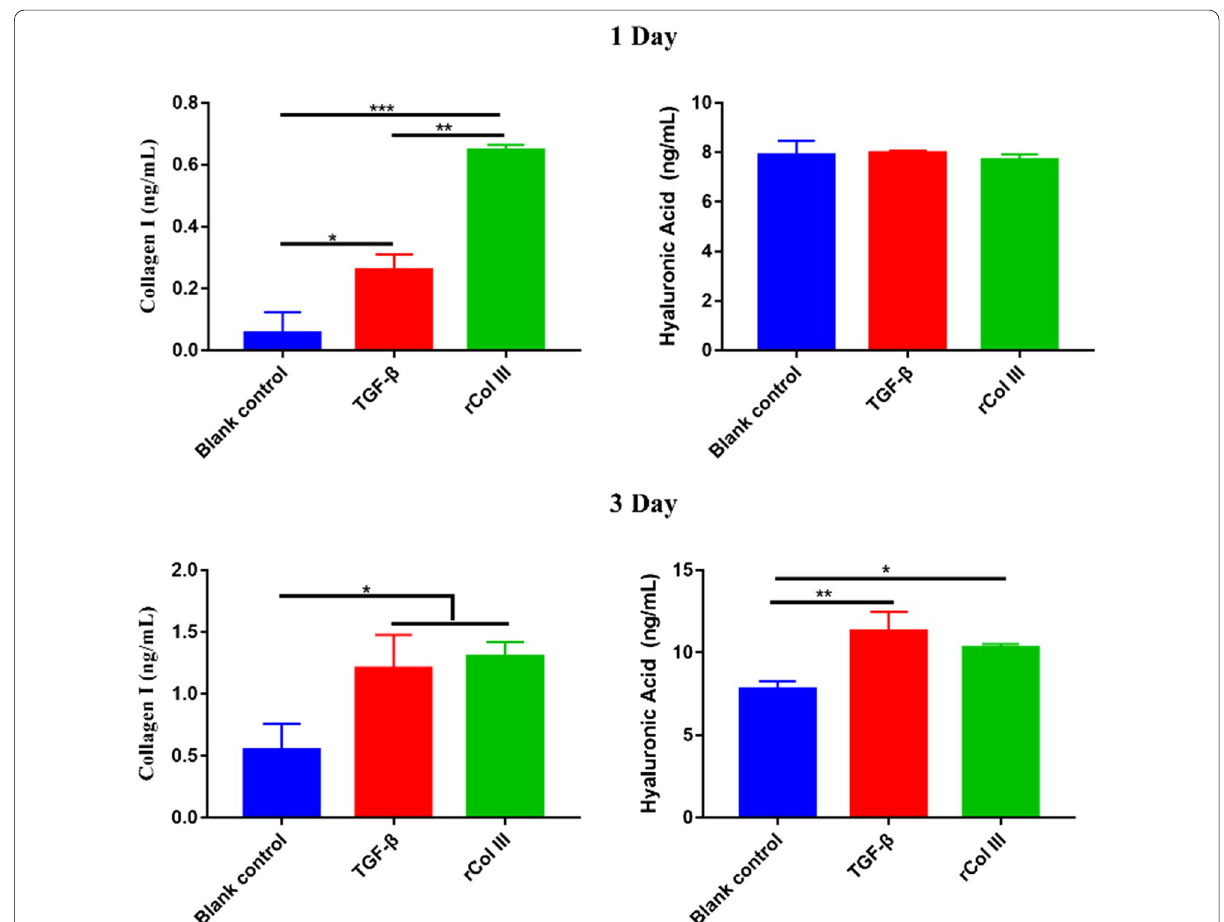
Fig. 8 Effect of rhCol III and TGF-β on ECM expression of HSF at the protein level (collagen I and